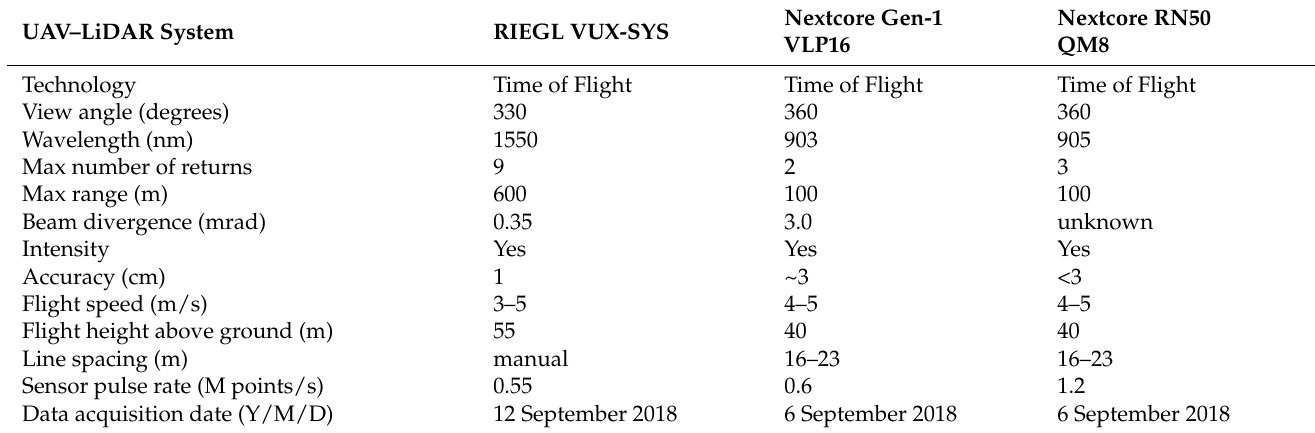
Table 1. System and flight